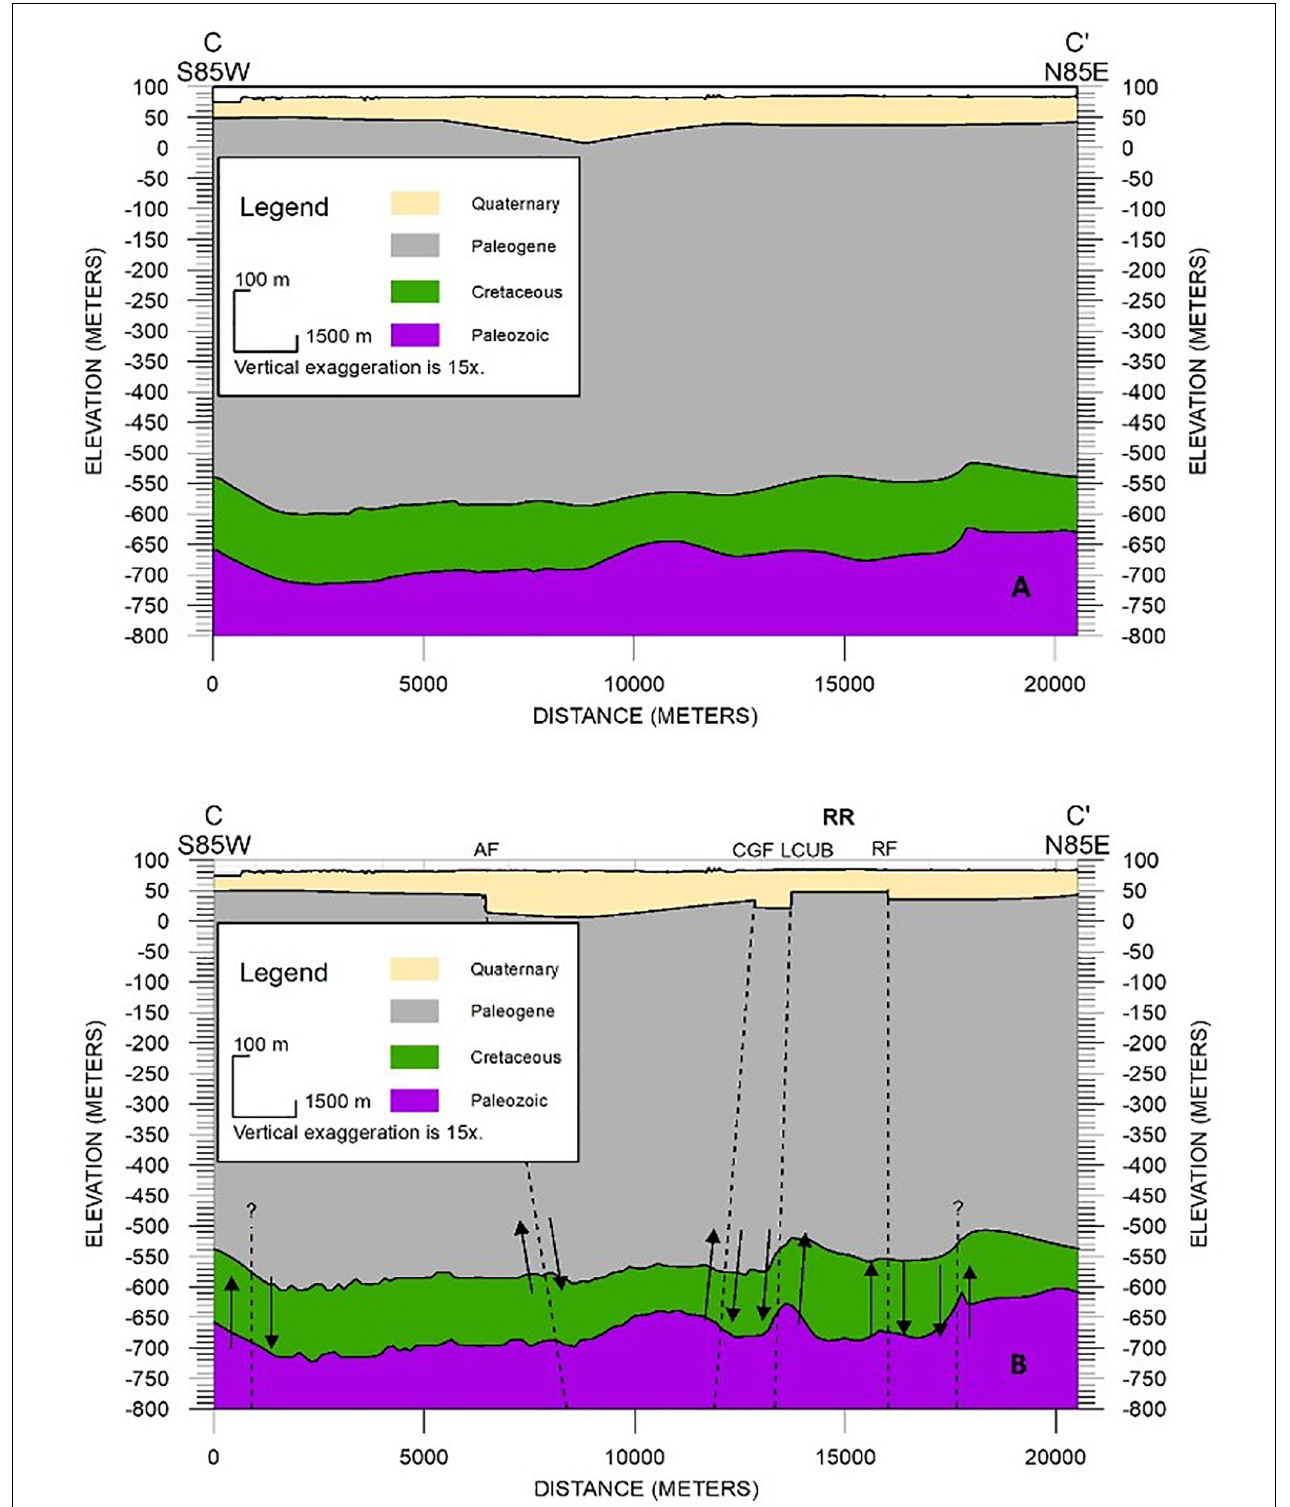
FIGURE 10 | (A) Cross-Section C-C’ (unfaulted) as located in Figure 3 shows the Quaternary alluvium (peach), Eocene (gray), Cretaceous (green), and Paleozoic (purple). (B) Faulted Cross-Section C-C’. RR, Ridgely ridge; AF, Axial fault; CGF, Cottonwood Grove fault; LCUB, Lake County uplift back thrust fault; RF, Ridgely fault. Vertical exaggeration =